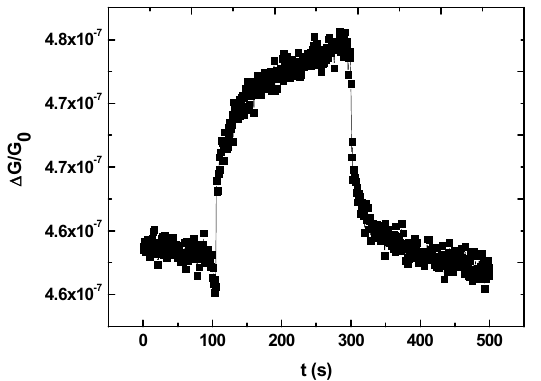
Figure 11. Response and recovery curve for WS 2 sensor to 240 ppm of NH 3 in ambient atmosphere.